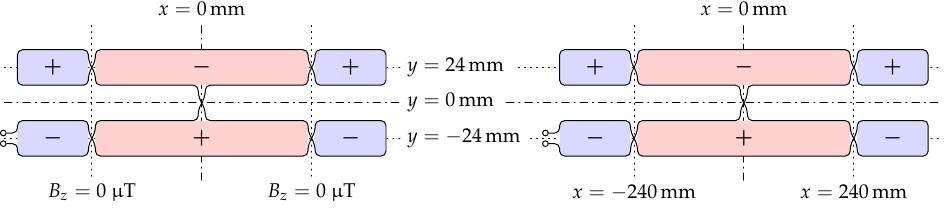
Figure 13. Schematic of the modified sensor coil 2—the signs represent the orientation of the conduc- tor loops, the colors indicate the induced voltage ( left ) Ideal shape ( right ) Realized version.